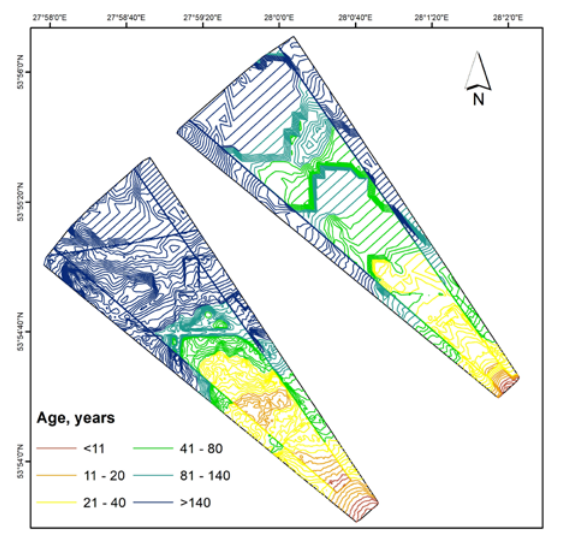
Figure 7. Age of the pine forest in reaching the maximum permissible